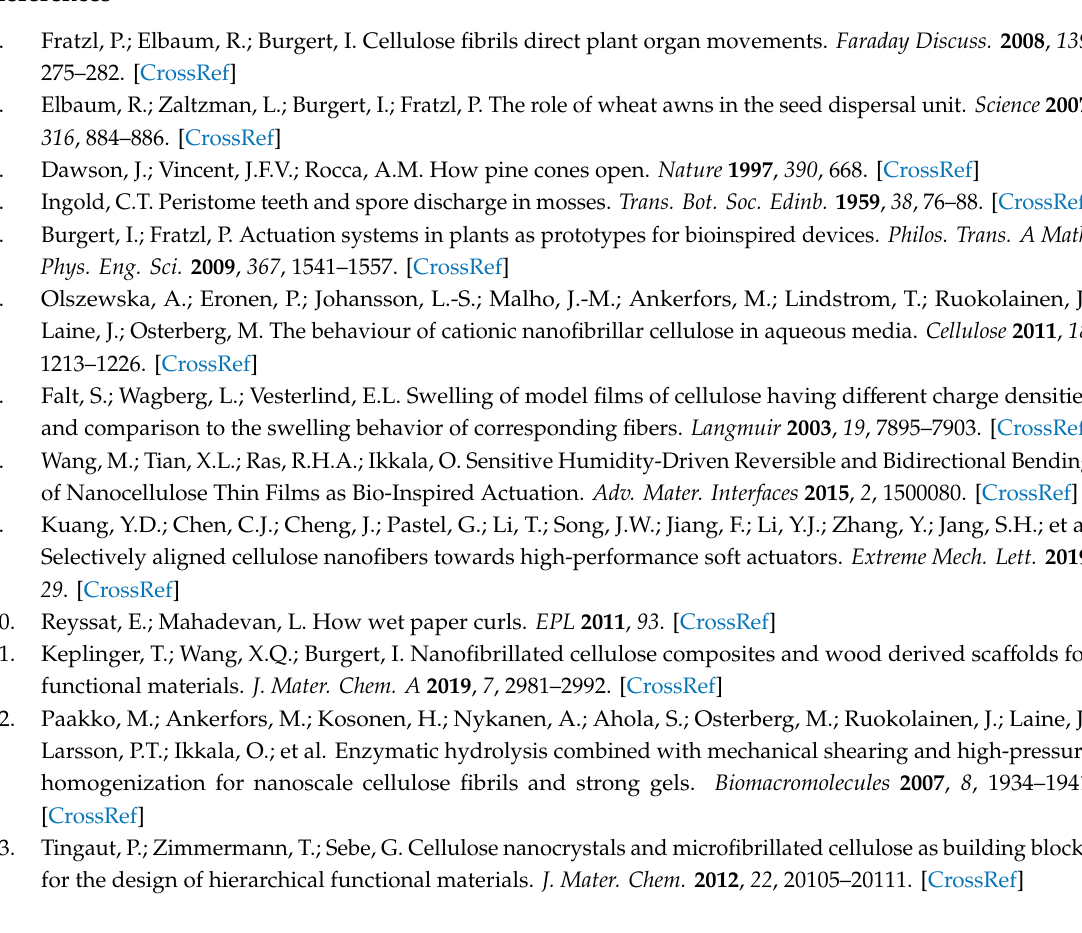
Figure S1: Conductometric titration curve of the TEMPO-oxidized NFC; Figure S2: Characterization of the actuation behavior of NFC films: maximal curvature ( κ max ), actuation time ( t a ) and actuation rate ( d κ / dt ); Figure S3: Photographs showing the bending of the NFC / TOCN9 films for the thicknesses 55 and 75 µ m when they were immersed in high pH (pH 13); and X-Y plots showing the evolution of the bending for the di ff erent times from 0 to 60 s; Figure S4: Curvature as a function of time of the TOCN9 / NFC / AMCN nanopapers immersed in low and high pH aqueous solutions (pH 1 and 13), respectively; Movie S1: Change in curvature of the NFC / TOCN5 film when it was immersed in high pH; Movie S2: Change in curvature of the NFC / TOCN9 film when it was immersed in high pH; Movie S3: Change in curvature of the TOCN9 / AMCN film when it was immersed in high pH; and Movie S4: Change in curvature of the TOCN9 / AMCN film when it was immersed in low